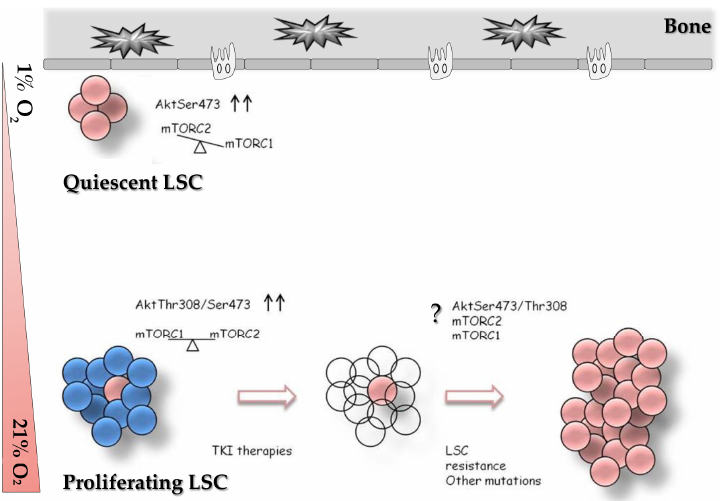
Figure 4. Proposed model of mTORC2 involvement in regulation of quiescent/proliferating LSC. Under low oxygen concentration (1% O 2 ) mTORC2 and Akt (Ser473) could be in an active state (arrows) at the expense of mTORC1. Otherwise, under normal oxygen concentration (21% O 2 ) a balance between mTORC1 and mTORC2, and consequently between Akt (Ser473) and Akt (Thr308) could be detected. The contribute of mTOR complexes on leukemia relapse is unknown (question mark), we proposed the possibility that mTORC2 can have a role in modulate the relapse, in association with other factors, e.g., mutations.